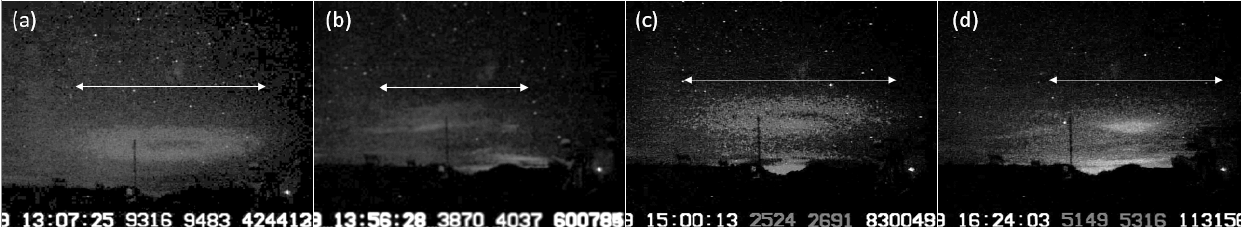
Figure 8. The low-light-level CCD system recorded images of elves at GPS time ( a ) 13:07:25.9316 (elve), ( b ) 13:56:28.3870 (sprite halo), seeing detailed in Figure 10, ( c ) 15:00:13.2524 (elve) and ( d ) 16:24:03.5149 (halo) on 22 June 2020 where images were enhanced to show their emission structure of elves and halos.